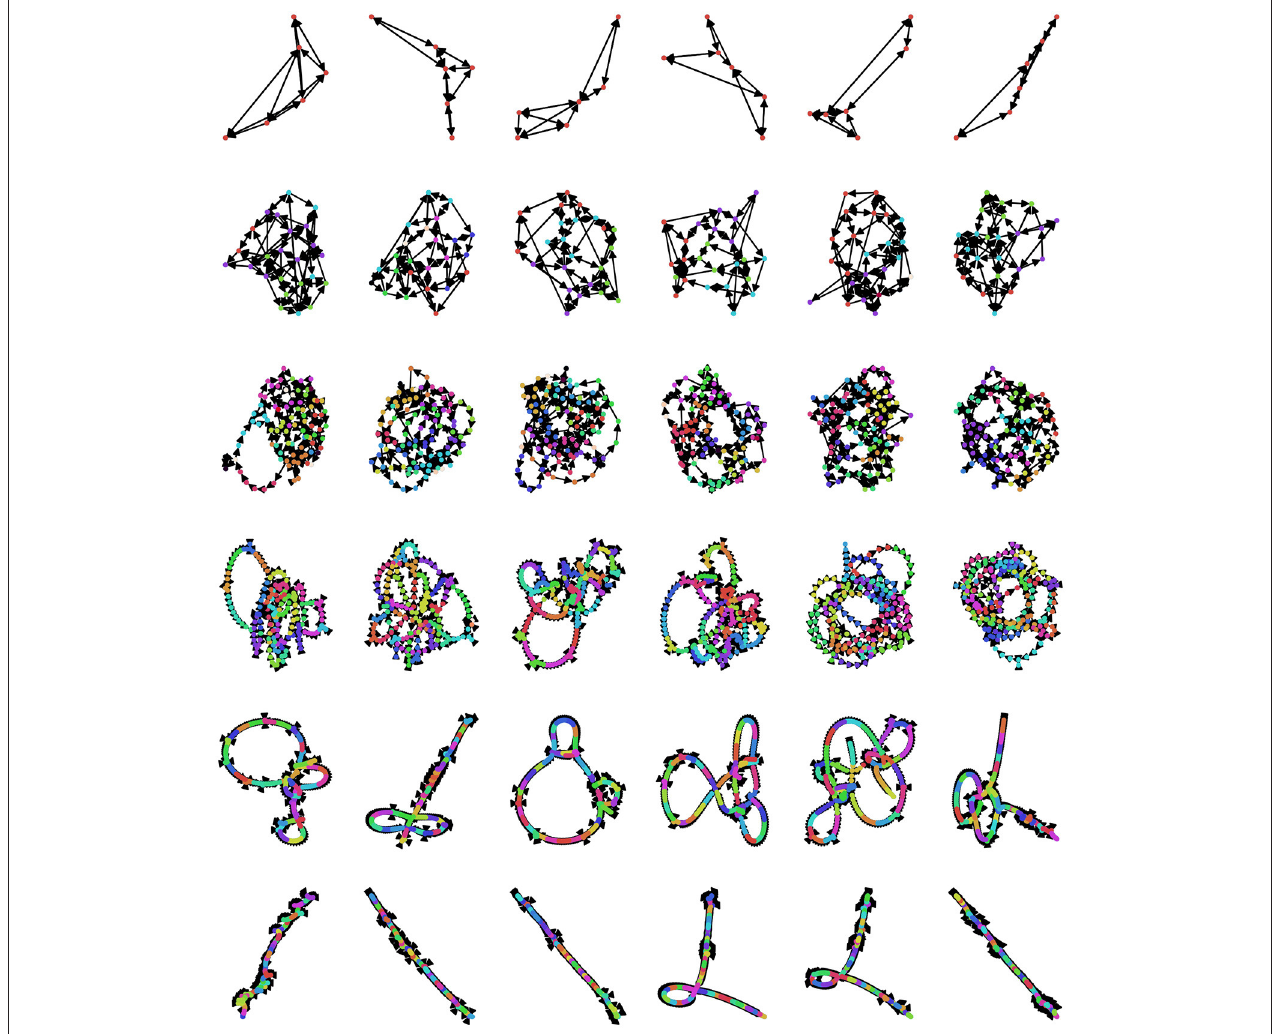
FIGURE 5 | Exploring the space of possible ordinal partition networks. Possible OPNs for a single time series with lags ranging from 12 to 24 (rows, in increments of 2) and dimensions ranging from 3 to 8 (columns). Nodes are colored according to community assignment determined using the Infomap algorithm (Rosvall and Bergstrom, 2008; Rosvall et al., 2009 ). Note that, as the embedding dimension gets large, the networks become increasingly path-like, as every embedded vector gets it’s own unique ordinal partition vector, creating an illusion of determinism. The data is the same Neurotycho time series as what was used above in Figure 4